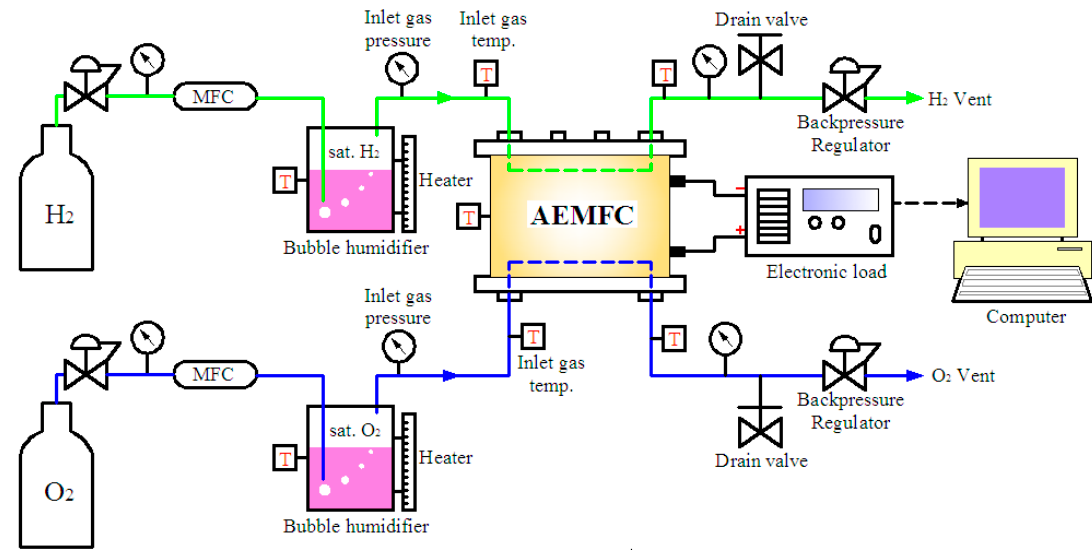
Figure 2. Schematic diagram of the FCED-PD50 test station.